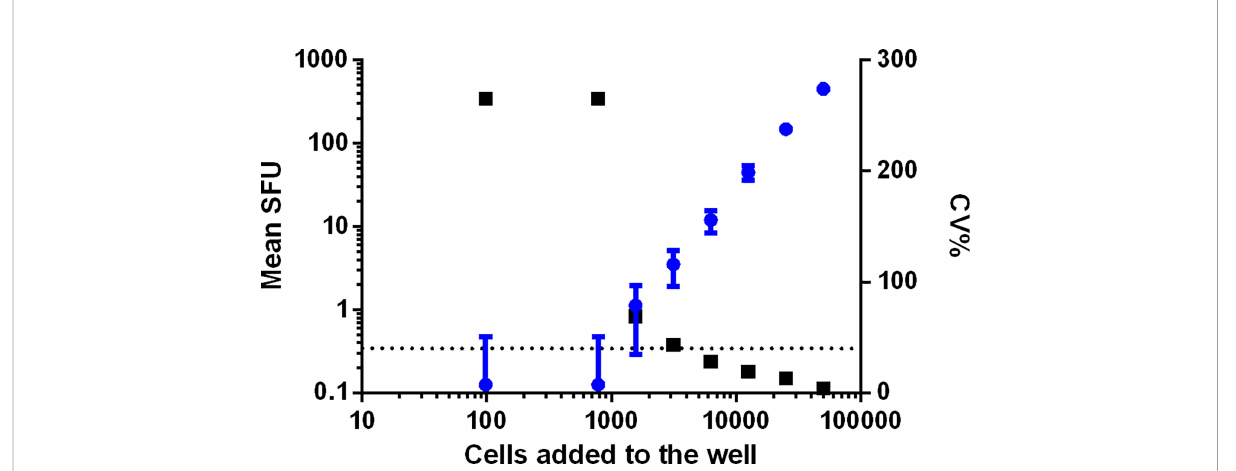
FIGURE 7 Determination of the ULOQ. PBMC from two samples were plated each on one plate in a serial dilution, ranging from 100 000 to 48 PBMC per well. Data from sample 1 is shown. Each condition was repeated 8 times and all cells were stimulated with SEB. Mean SFU with SD bars is indicated in blue and represented on the left y-axis. The related CV% are shown in black and represented on the right x-axis. The dotted line indicates the acceptance criterion of 40%